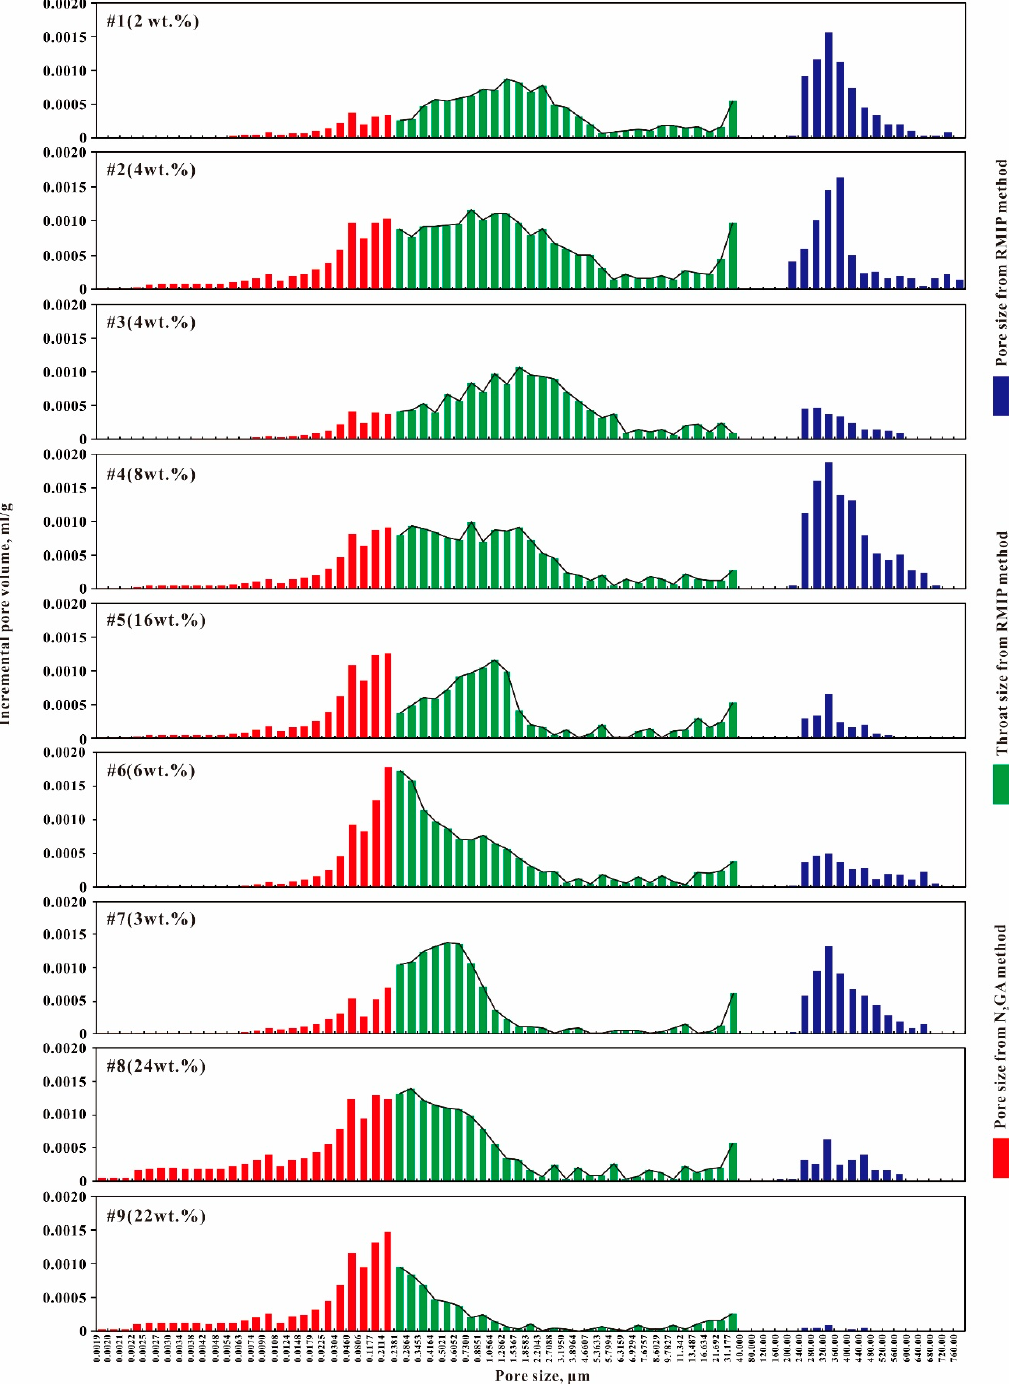
Figure 8. Pore size distributions of nine tight rock samples with various contents of clay minerals and permeability analyzed by nitrogen gas adsorption (N 2 GA) and RMIP experiments. The number inside the parentheses is the content of clay minerals.